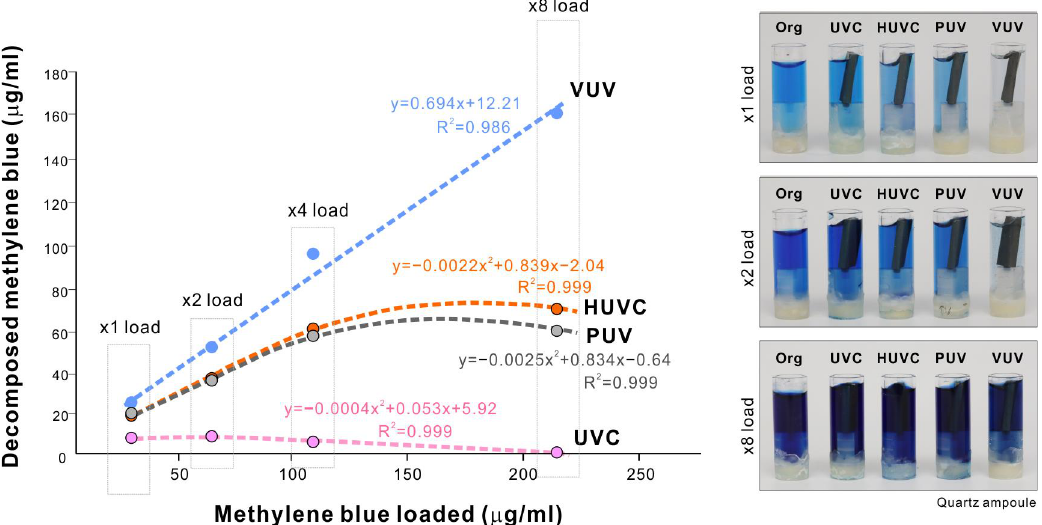
Figure 8. Load testing of organic decomposition induced by four different UV light sources. Methylene blue at four different concentrations (1× to 8×) in a quartz ampoule was treated with four different UV light sources for 1 min. Remnant methylene blue is plotted against the methylene blue concentration along with results of the regression analysis. Note that a linear positive correlation was only found for VUV, while the other UV sources fitted a polynomial equation. Representative photographs of the methylene blue solutions are presented.